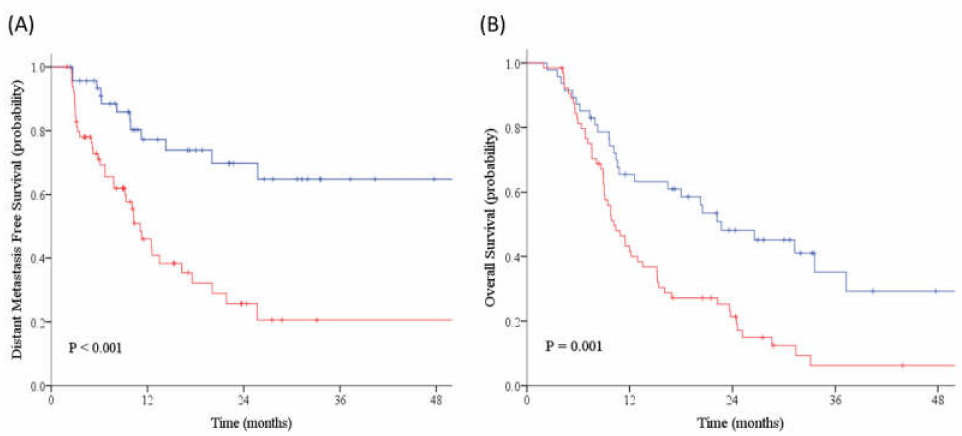
Figure 3. The Kaplan–Meier estimates of ( A ) distant metastasis-free survival (DMFS) and ( B ) overall survival (OS) for patients with SUV LN / SUV Tumor ≥ 0.39 (red line) versus SUV LN / SUV Tumor < 0.39 (blue line). High SUV LN / SUV Tumor ( ≥ 0.39) predicted for worse outcomes than low SUV LN / SUV Tumor ( < 0.39) on DMFS (two-year: 26% vs. 70%, p < 0.001) and OS (two-year: 21% vs. 48%, p = 0.001). Table 2. Correlations between SUV LN / SUV Tumor and other clinical prognostic factors. SUV LN / SUV Tumor Characteristics Correlation Coe ffi cient a P